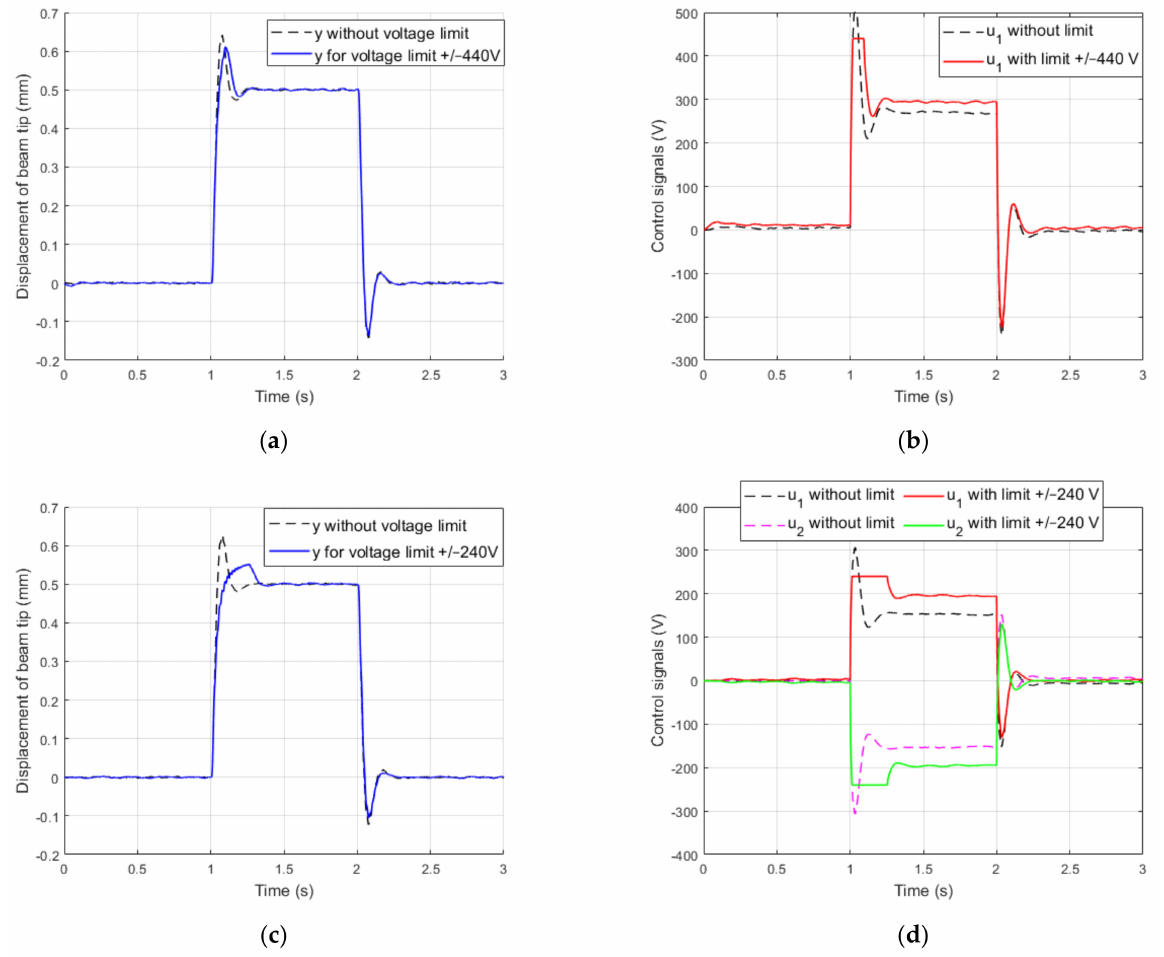
Figure 8. Control system characteristics for r 11 and r 22 equaled 1/150 2 : ( a ) Output for one-input for voltage limit ± 440 V; ( b ) Control signals for one-input for voltage limit ± 440 V; ( c ) Output for two-input for voltage limit ± 240 V; ( d ) Control signals for two-input for voltage limit ± 240